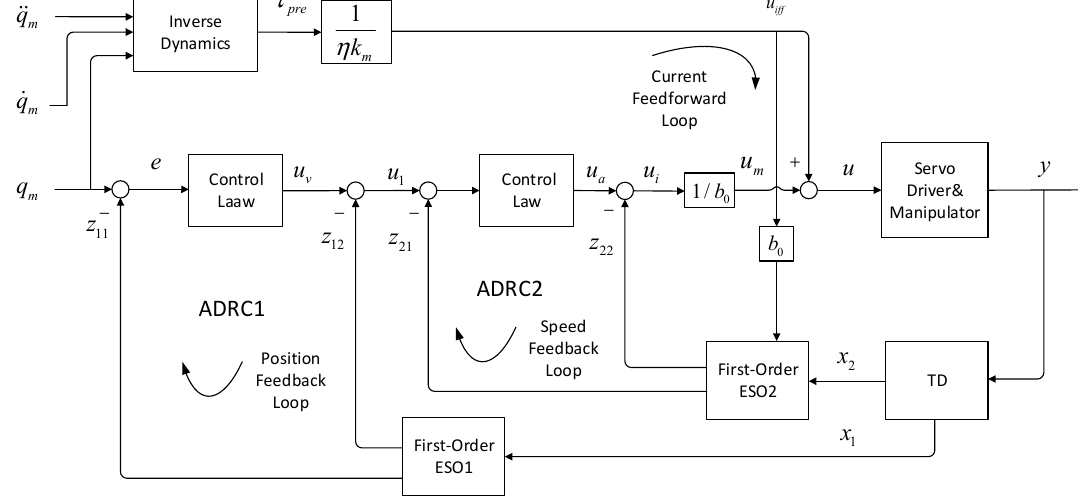
Figure 6. Active disturbance rejection control (ADRC) cascade controller based on inertia feedforward.